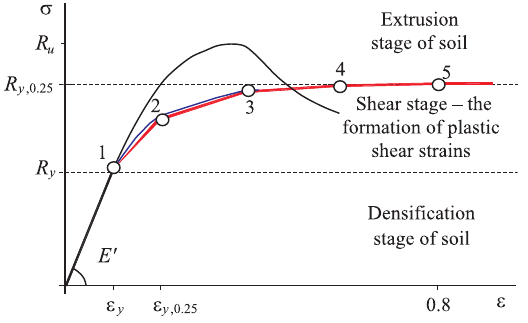
Fig. 2. The stamp test: idealized diagram of soil σ - ε dependency